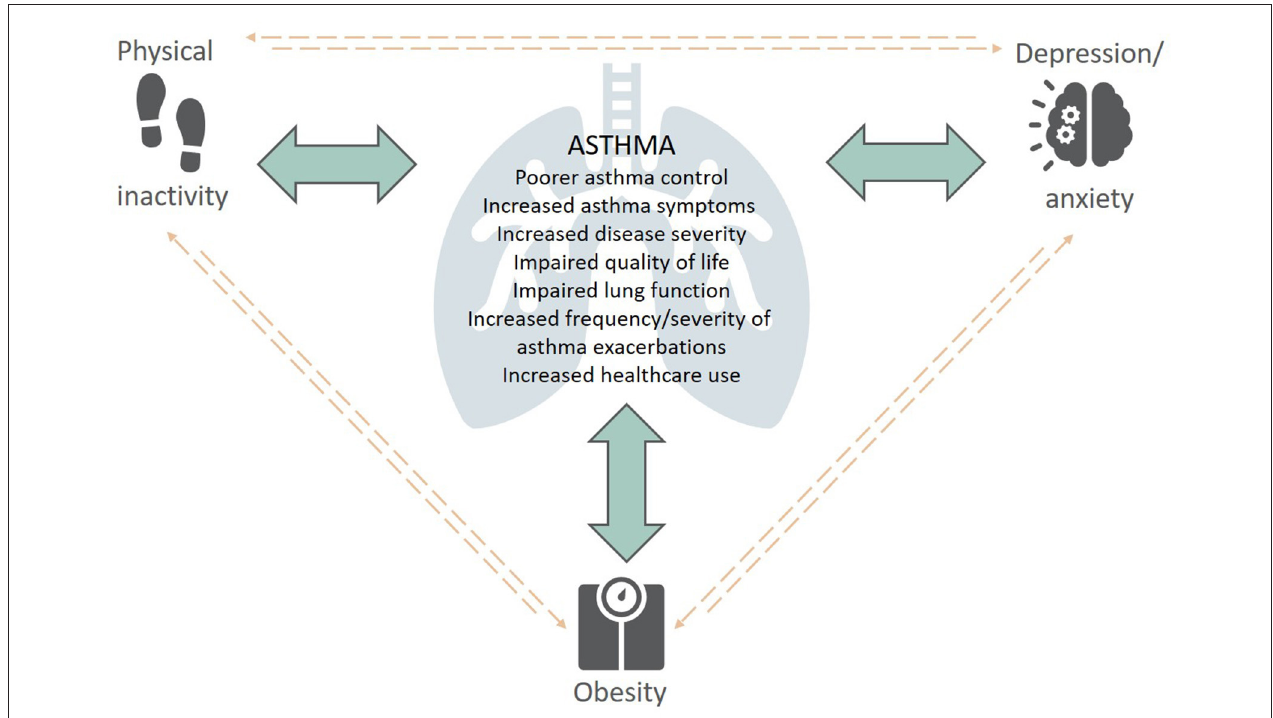
FIGURE 1 | The complex interplay between extrapulmonary traits (physical inactivity, obesity, depression/anxiety) and asthma—Content has been reproduced with permission from the Centre of Excellence in Treatable Traits, originally developed as part of the Centre of Excellence in Treatable Traits